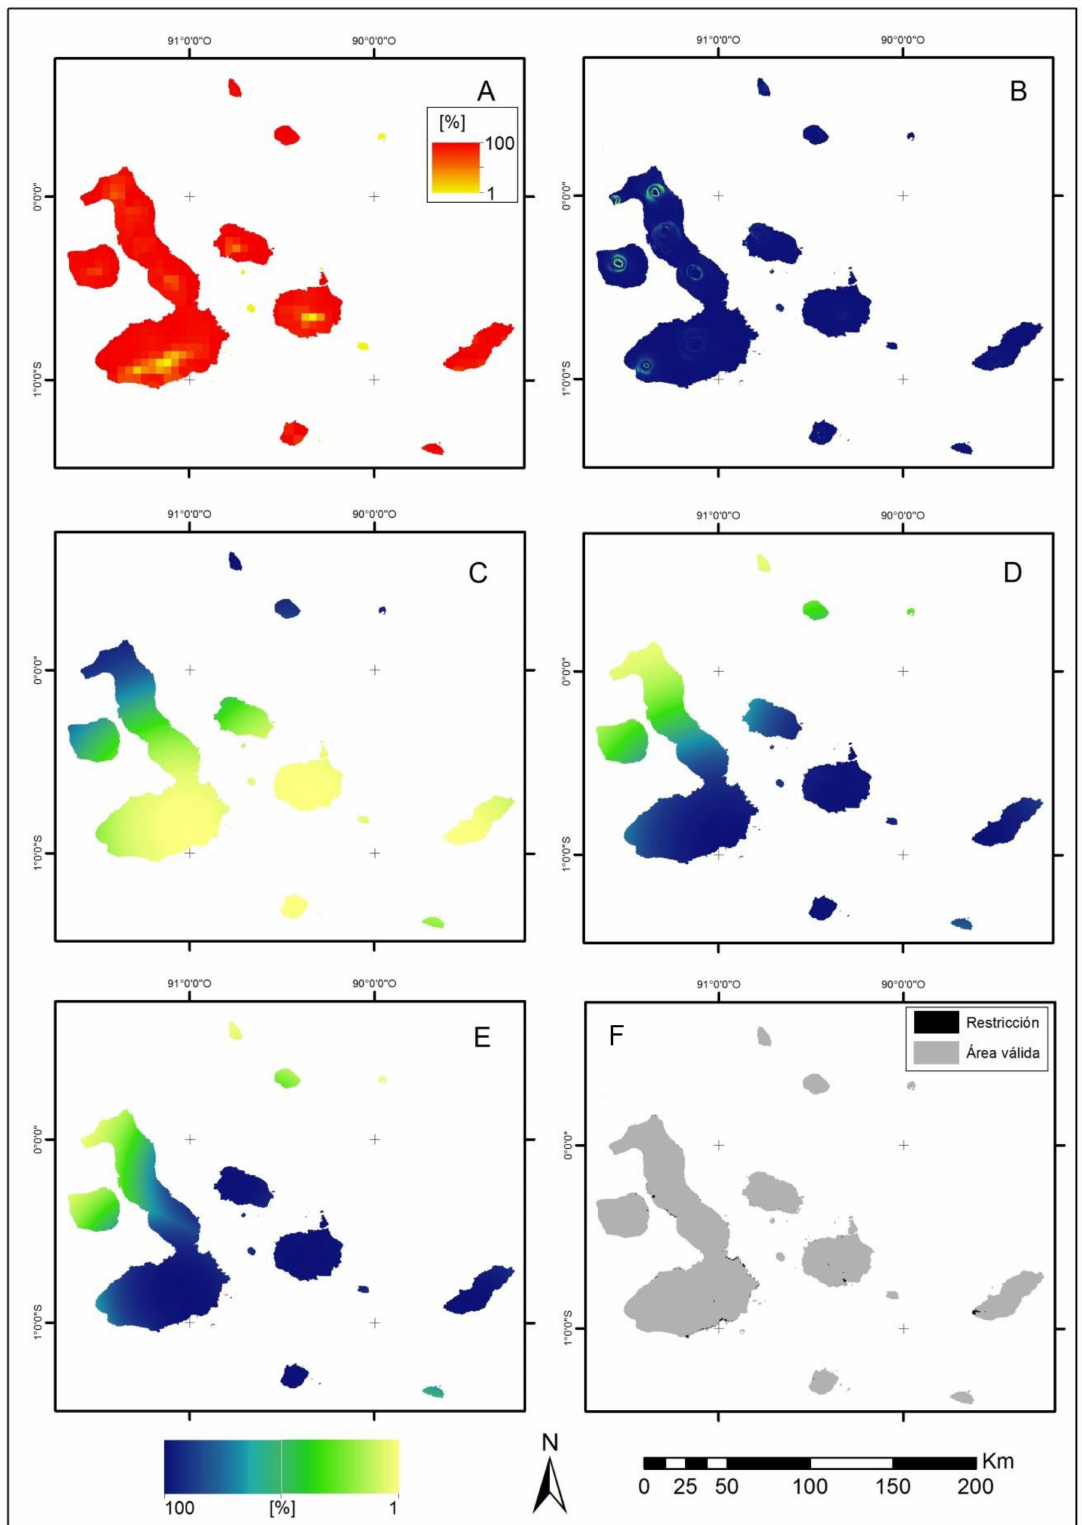
Figure 3. Layer preparation for MCDM on solar plants. ( A ) Global solar radiation. ( B ) Terrain slope ( C ) Distance to urban areas. ( D ) substations distance. ( E ) Distance to the road network. ( F ) restricted/empty